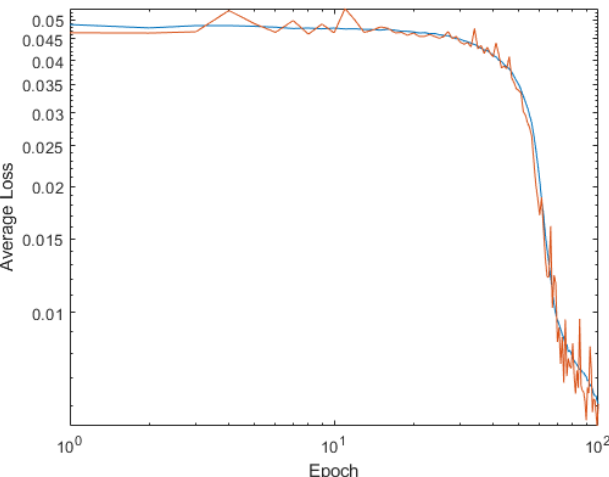
Figure 24. Average loss on training patterns in blue and validation patterns in orange for Standard SGD of Drop-Wave function.